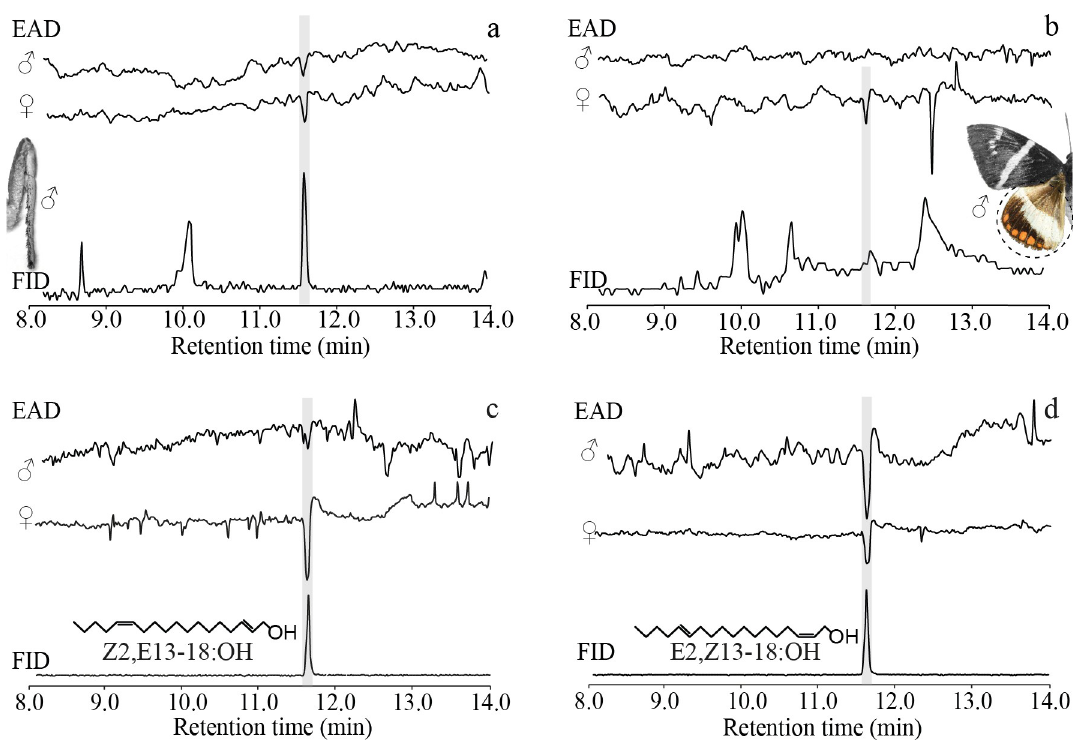
Fig 7. Gas chromatographic analyses of extracts and synthetic references using simultaneous detection with FID and EAD. (a) Male midlegs. (b) Male hindwings. (c) Z2,E13-18:OH. (d) E2,Z13-18:OH. GC-EAD equipped with an Rtx-5 capillary column; 3 antennae were used for each extract or